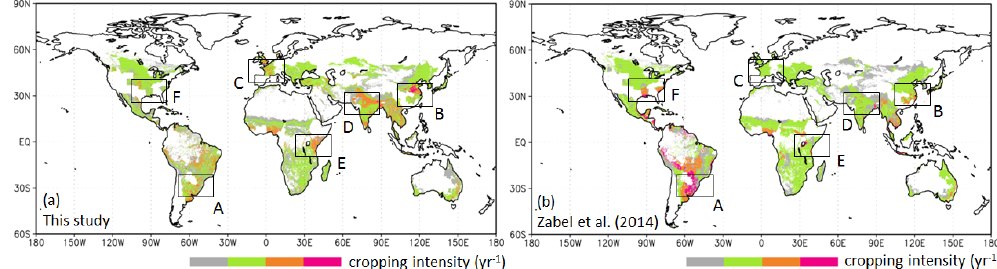
Figure 5. Global distribution of (a) detected cropping intensity in this study and (b) climate-based estimation of cropping intensity suitability (i.e., maximal cropping intensity; Zabel et al., 2014). The cropping intensity of the dominant crop is illustrated in Fig.